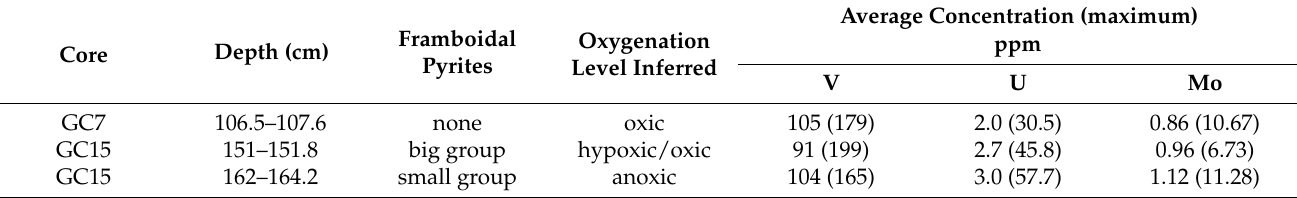
Table 3. Trace metal concentration in three embedded blocks analysed by LA-ICP-MS representative of 3 different oxygenation conditions in bottom